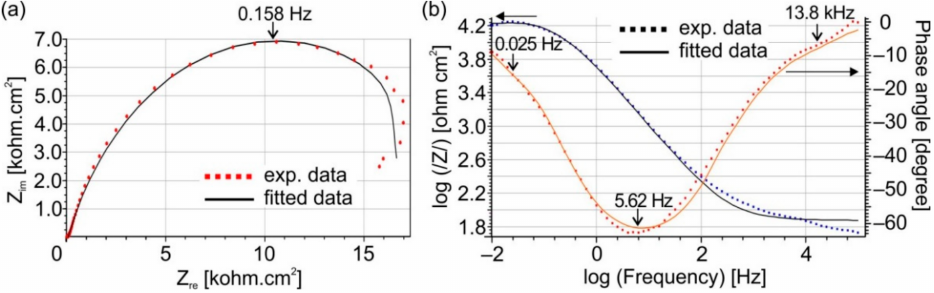
Figure 7. ( a ) Nyquist and ( b ) Bode plots of silver-coated copper in 3.5 wt.% NaCl aqueous solution.